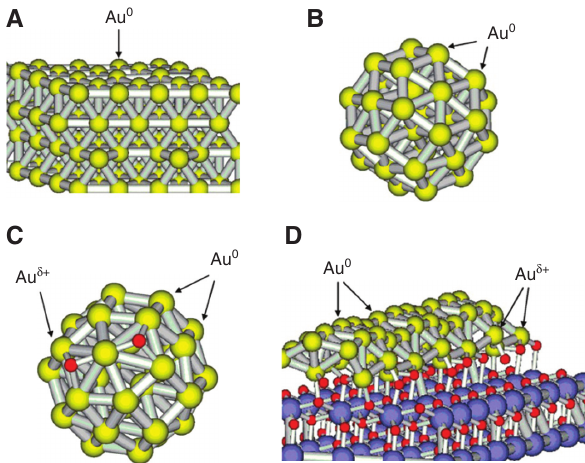
Figure 2 Optimized structures of the gold catalyst models used in the theoretical study: (A) Au(111) facet containing high-coordinated neutral Au 0 atoms, (B) Au cuboctahedral particle containing low- 38 coordinated neutral Au 0 atoms, (C) partially oxidized Au particles 38 (Au O ) containing low-coordinated metallic Au 0 and cationic Au δ + 38 2 sites, and (D) Au/CeO model containing neutral Au 0 atoms on top 2 of the rod and cationic Au δ + sites at the metal-support interface. Au, yellow; O, red; Ce, blue. From [27] with